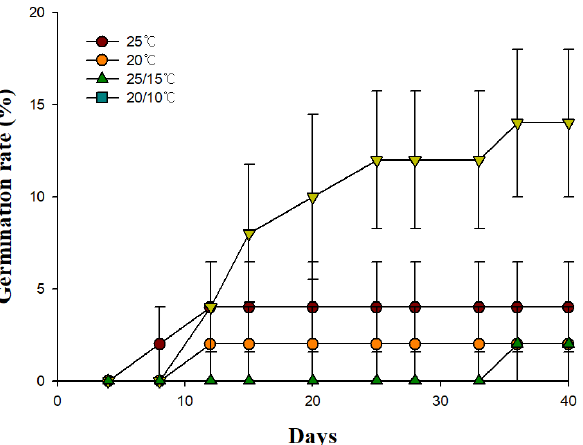
Figure 2. Effect of temperature treatments on the cumulative germination rate (%) in seeds of L. coreana . Bars indicate standard error ( n = 5). It shows the germinated temperature treatments, excluding the non-germinated (5 and 15 ◦